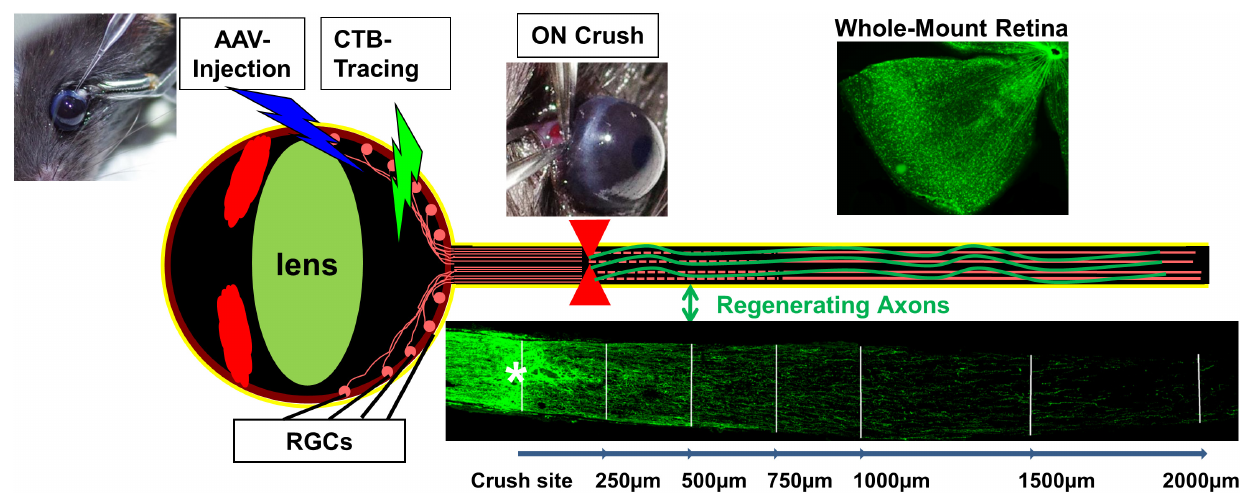
FIGURE 1 | RGC/ON crush provides a straightforward in vivo CNS axon injury/regeneration model with clear readout, easy access and amenable to genetic manipulation. Mouse eye can be injected with AAV for genetic manipulation of RGCs and fluorescence-labeled CTB for regenerating axon tracing. Whole-mount retina is for RGC detection and ON longitudinal cryostat section is for visualizing regenerating